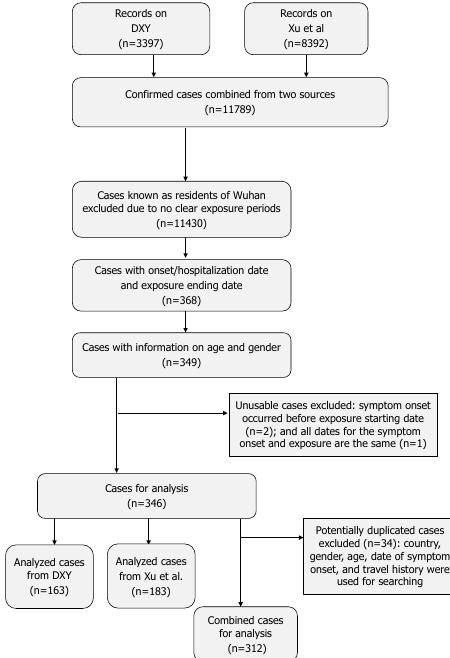
Figure 1. Flow diagram of confirmed cases for data analysis. Two data sources were combined from DXY [9] and Xu et al.